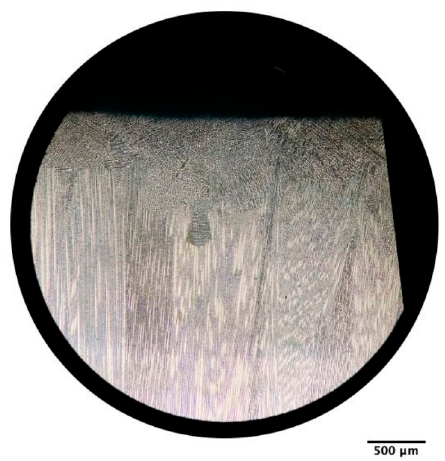
Figure 9. Cross section of in the x-z plane (x being the torch moving direction and z being the height) of the Inconel 718 30-layer wall structure.